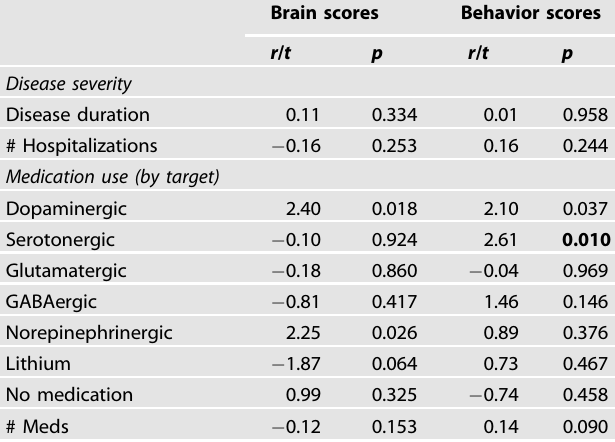
Table 2. Post-hoc associations between participants ’ brain (or behavioral) scores, disease severity, and medication use (categorized by the neurotransmitter